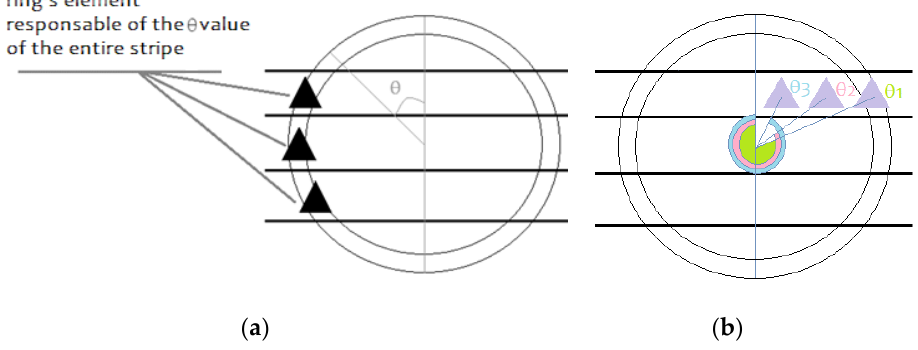
Figure 11. Qualitative scheme for assigning θ value ( a ) to upwind inside elements and ( b ) to downwind inside elements.